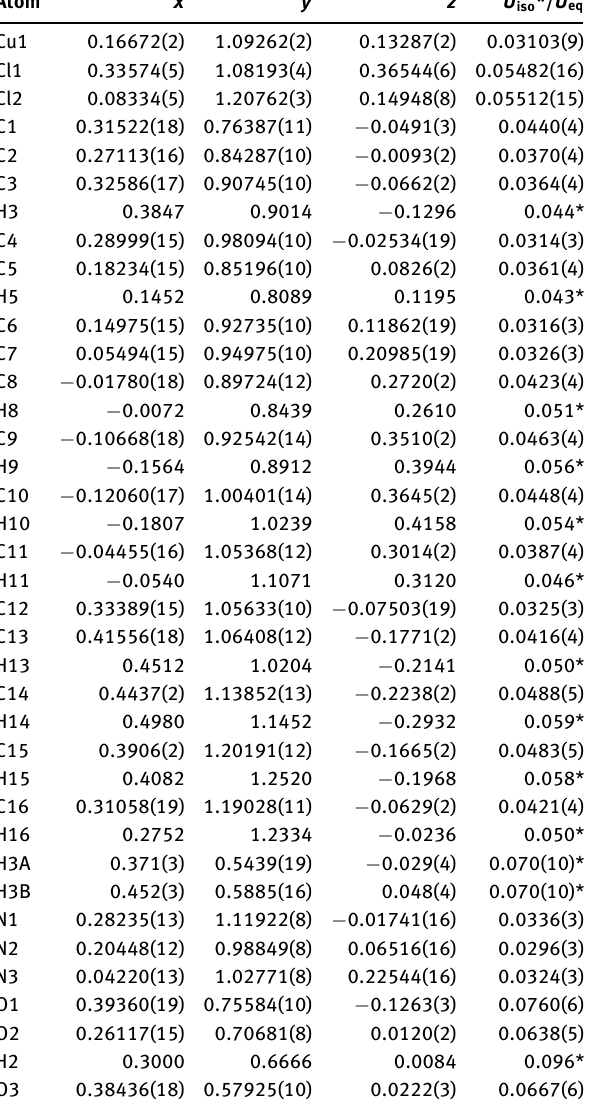
Table 2: Fractional atomic coordinates and isotropic or equivalent isotropic displacement parameters (Å 2